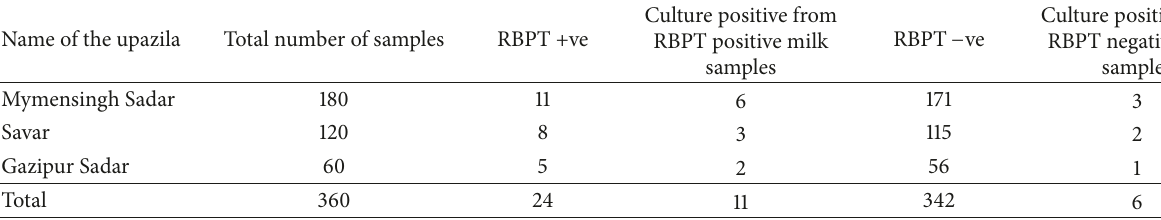
Table 1: Results of RBPT and culture of seronegative dairy cows samples.